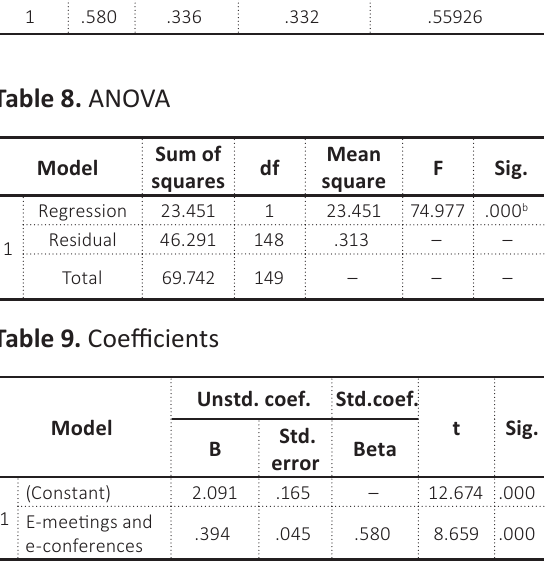
Table 7. Model summary